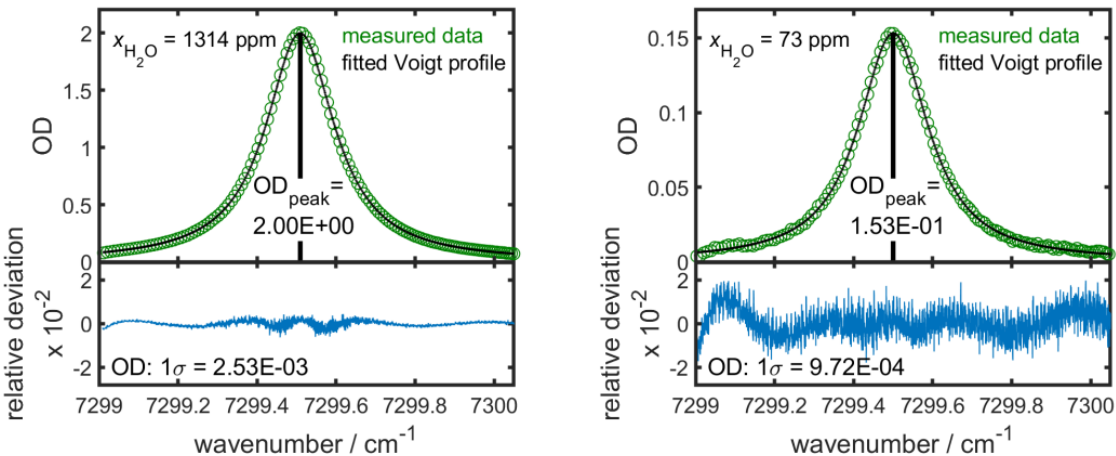
Figure 3. Top : Typical H 2 O absorption line (measured data (circles) and fitted Voigt profile (solid line)), after removal of amplitude modulation and correction for offset and transmission fluctuations, for high ( left ) and low water vapor concentration ( right ), plotted as optical density ( OD = − ln ( I / I 0 ) ) over a linear wavenumber scale. Bottom : Deviation between measured data and fitted Voigt profile normalized to respective maximum values.